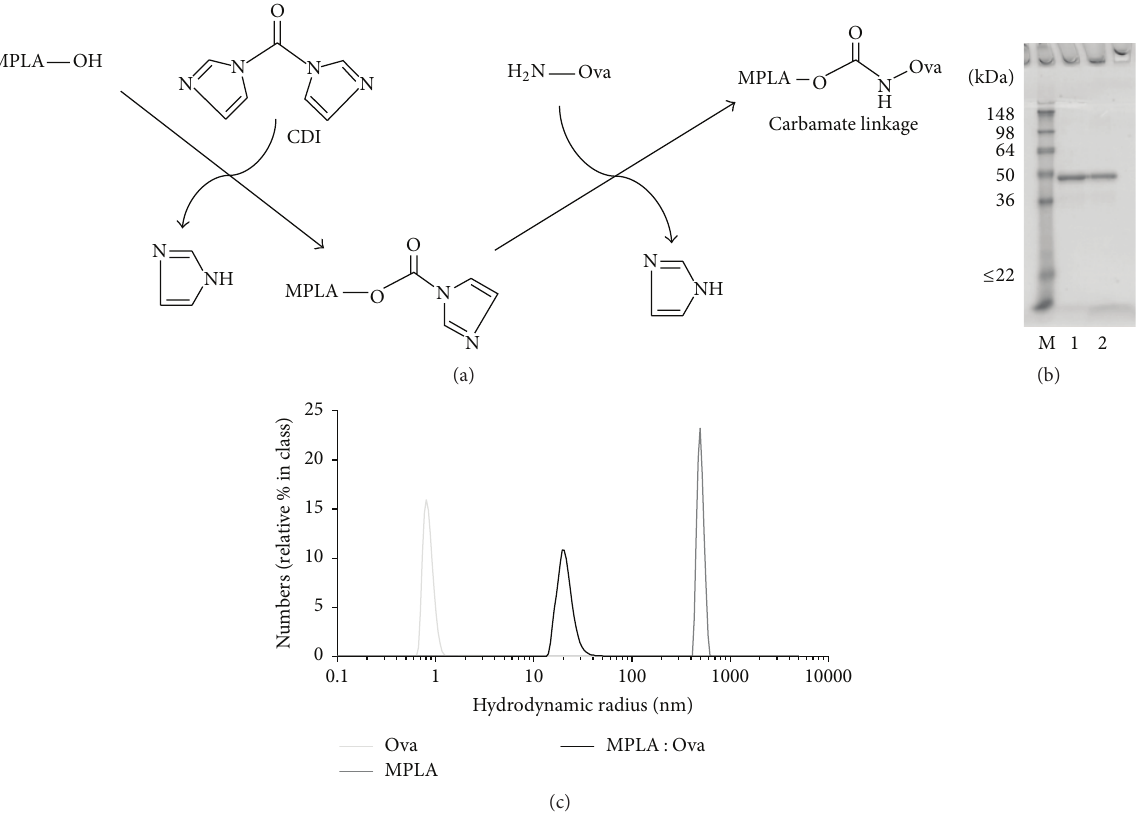
Figure 1: Generation of MPLA: Ova fusion protein. Applied chemical coupling strategy (a). Analysis of MPLA: Ova by reducing SDS-PAGE (b, M: molecular weight marker, 1: EndoGrade Ova, and 2: MPLA: Ova) and dynamic light scattering (c). For light scattering analysis, 70 𝜇 L of MPLA (1mg/mL), MPLA:Ova (0.6mg/mL), LPS (1mg/mL), or Ova (1mg/mL) in PBS was analyzed at room temperature. Three individual measurements per sample were performed and the mean frequencies (calculated as relative % in class) of hydrodynamic radii ( 𝑟 H ) in nm were